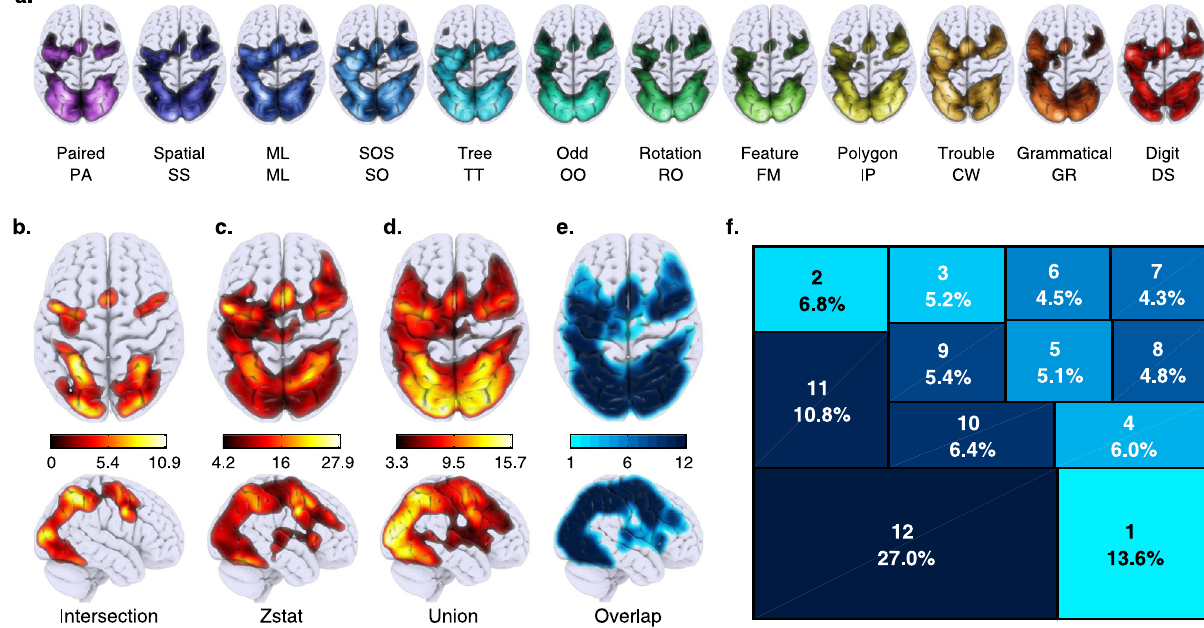
Fig. 1 Domain-general overlap volumes. We used a cognitive battery designed to measure different aspects of intelligence to collect task-evoked brain activation data from 60 participants. A description of each task is provided in Supplementary Methods A.1 and graphical representations in Fig. S1 and Supplementary movies 1 – 12. a Maximum intensity projection for the voxel-wise activation patterns (vs resting period) for the 12 cognitive tasks composing our battery. Initials for each task are displayed underneath simpli fi ed task names. b – d Maximum intensity projection for the following: b the intersection of the 12 tasks, i.e., voxels that were active for all of the tasks. c t -test across the 12 tasks relative to rest, i.e., tasks that were reliably active for multiple tasks. d Union of the 12 task activation patterns, i.e., voxels that were active for at least one task. e Proportion voxel-wise overlap projection (i.e. the number of tasks a voxel is activated by (darker colour = voxels present in more tasks). f Treemap quantifying the multi-way proportion of logical intersections of positive activation patterns across tasks. Top digit indicating the number of overlapping tasks and the bottom the percentage of voxels existing in the k-way intersection. Colour matches the overlap 12 tasks used here onto three orthogonal psychometric factors, visuospatial (VS), reasoning (RE) and verbal reasoning (VR) (Fig. 3a, b). As predicted by network sampling theory, the psy-